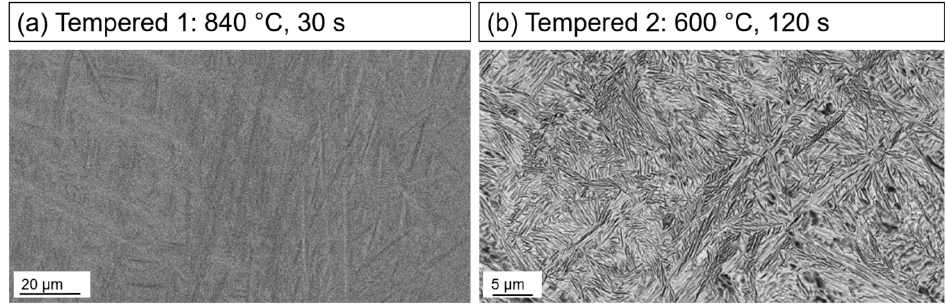
Figure 5. ( a ) SEM images (BSE) of R.T. microstructure in intermediate state after high-temperature tempering (T1) and ( b ) after reheating to service temperature (T2).